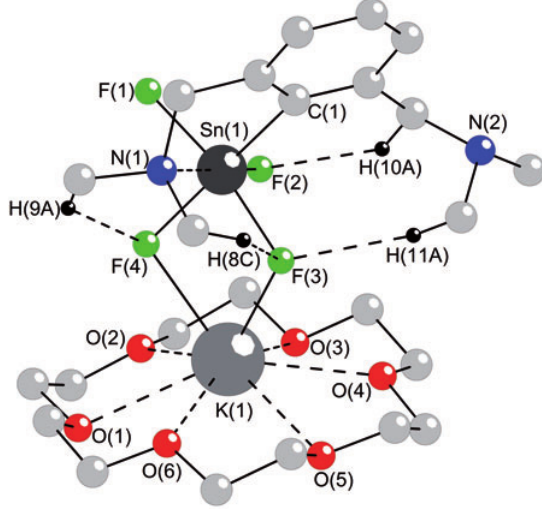
Figure 2 View of the intramolecular hydrogen bonding system (only the hydrogen atoms involved in intramolecular interactions are shown) in the [K(18-crown-6)] + [{2,6-(Me ] – crystal. SnF 4 and F(4) · · · H(9A) (2.267 Å ) interactions being shorter methyl than the sum of the van der Waals radii of the corresponding atoms [cf. Σ (F,H) 2.55 Å ] (Emsley , 1994 ), see Figure 2 , vdW